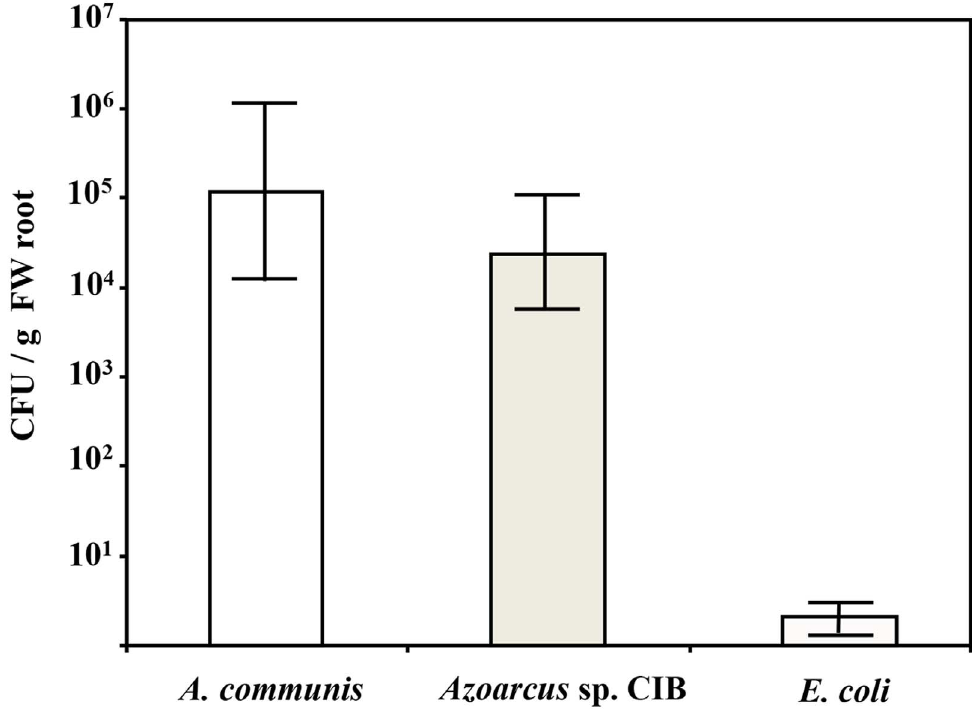
Figure 3. Quantification of the bacterial endophytic population within inoculated rice roots. Rice seedlings were inoculated with Azoarcus communis Swub3 ( A. communis ), Azoarcus sp. CIB ( Azoarcus sp. CIB), and E. coli S17-1 l pir ( E. coli ) containing plasmid pSEVA23GFP) that expresses the gfp gene as indicated in Materials and Methods. Plants were grown at 25 u C for 5 days, and the kanamycin-resistant bacteria within the root tissue were determined as detailed in Materials and Methods. Graphed values of CFU per g of fresh root (FW) are the average from three independent experiments + / 2 S. D. doi:10.1371/journal.pone.0110771.g003 PLOS ONE |